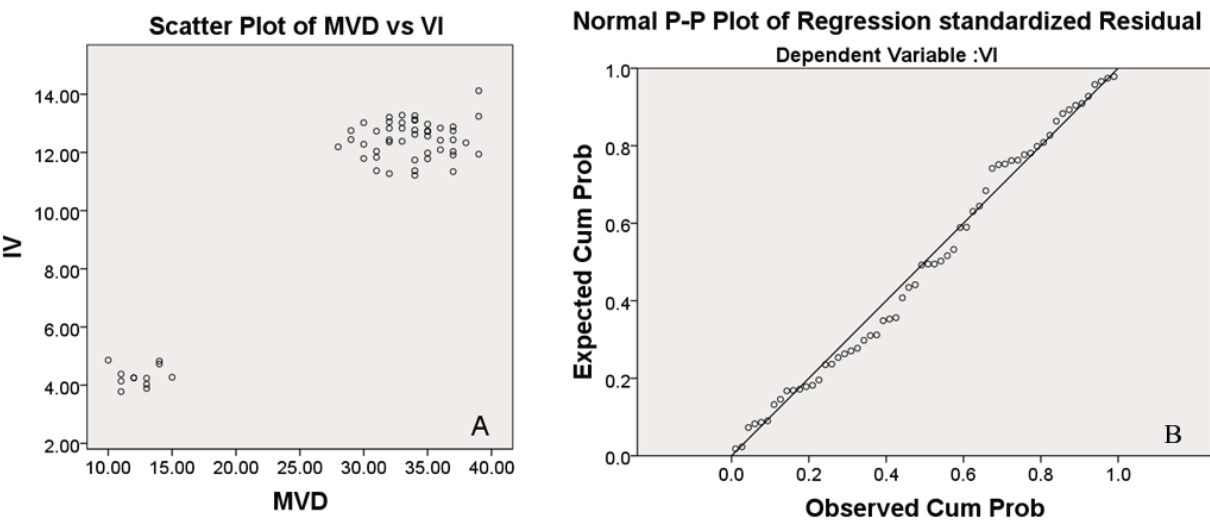
Figure 7. r = 0.95 ， p = 0.001, GFI = 0.903, Correlation analysis of the two methods were significantly associated at the level of 0.01 (double side, A ); Regression index analysis: b = 0.352, p = 0.001 for additional 1 in MVD, VI will increase 0.352, t -test was passed at level of 0.05 (double side, B